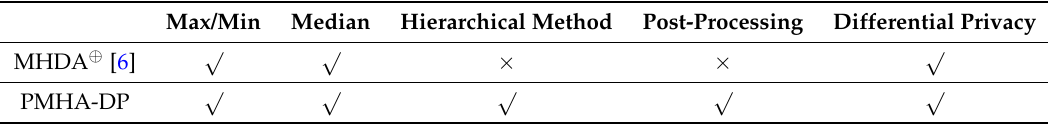
Table 2. Comparison of the functionality of non-additive